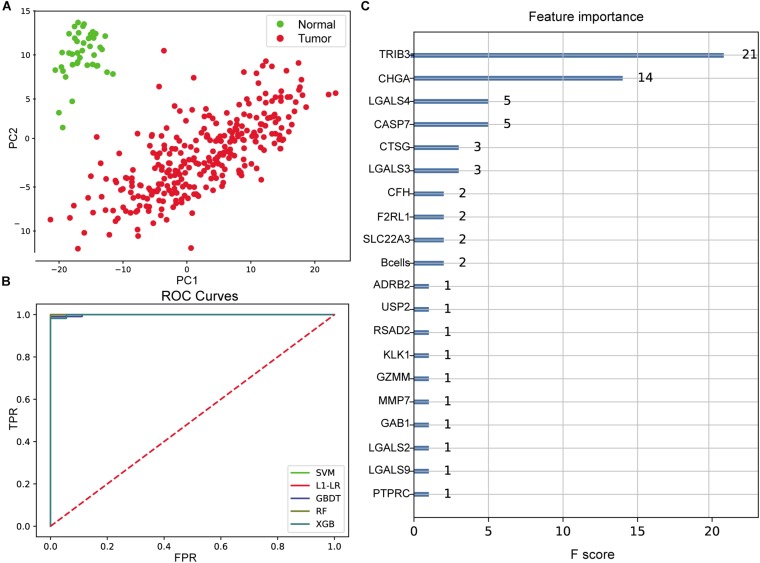
Evaluation of colon cancer diagnostic model. (A) Principal component analysis (PCA) of two-dimensional visualization results. PC1 and PC2 represent the first two principal components with the largest variance in PCA results, respectively. (B) Receiver operating characteristic (ROC) curves of model. FPR represents false positive rate [FP/(FP + TN)], and TPR represents true positive rate [TP/(TP + FN)]. The greater the area between ROC curve and X-axis (area under the curve value, between 0 and 1), the better the model effect. Different models are represented by different color curves. (C) The 20 most important features evaluated by XGB model. F score means the importance of the feature (the larger F score means the greater contribution of the feature to the model).